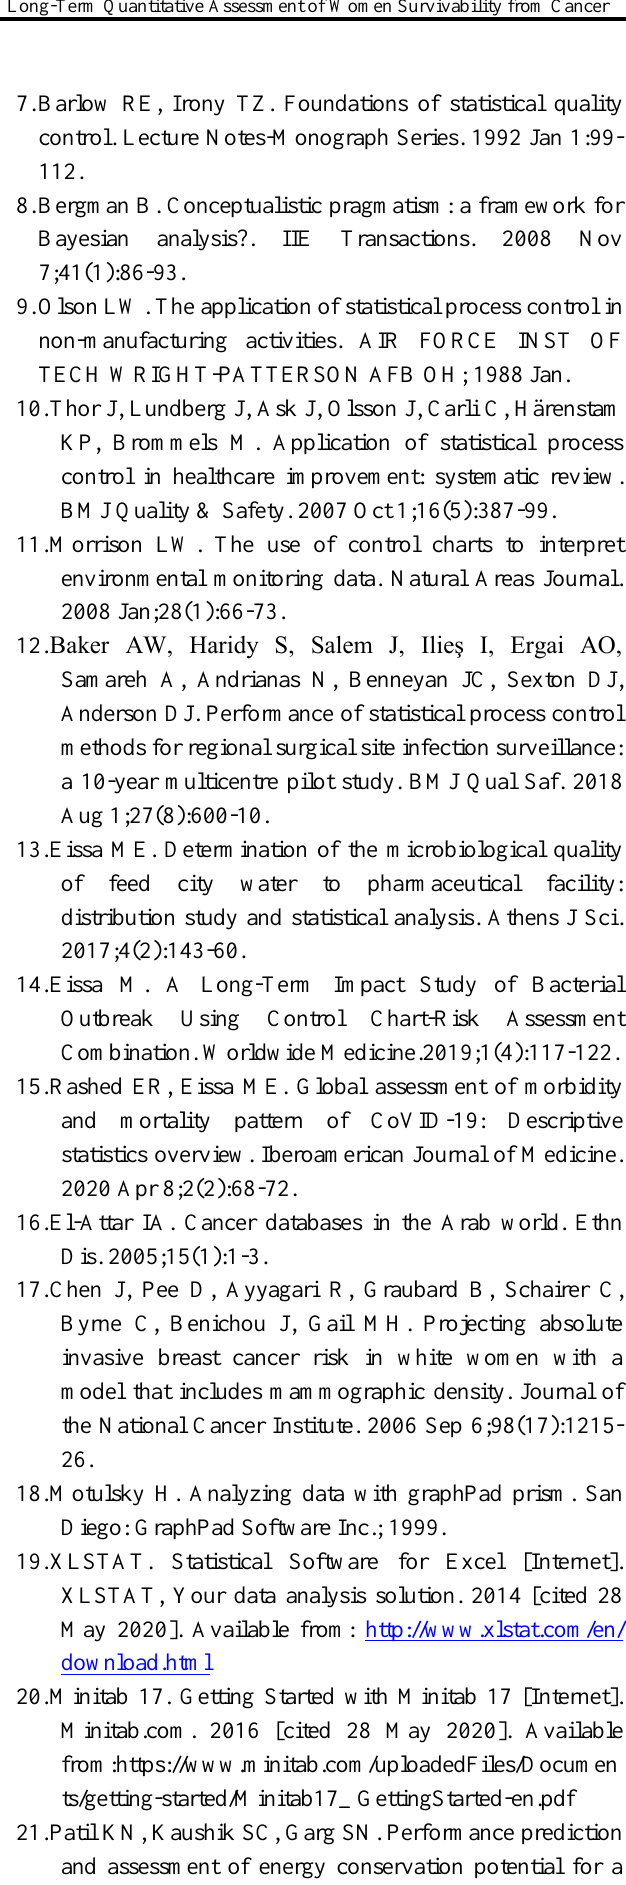
Supplementary Table S1: List of countries whose data have been used in this study and their corresponding